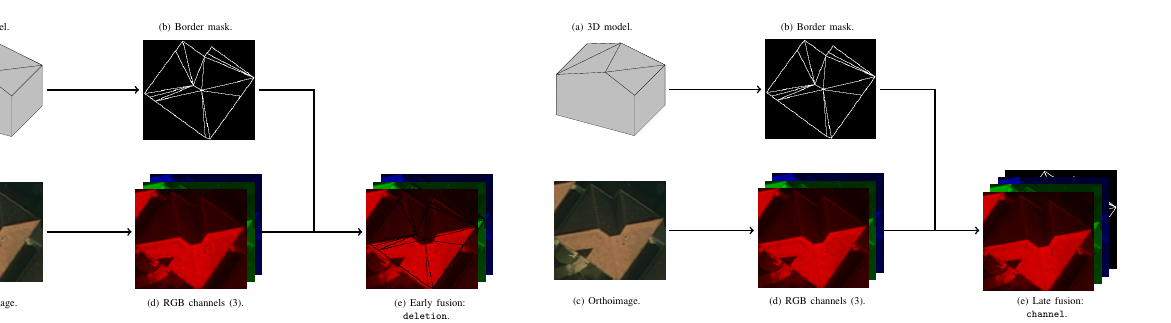
Figure 4. Late fusion scheme ( channel ). The mask indicating the pixels that intersect the edges of the nadir projection of the model is added as a fourth